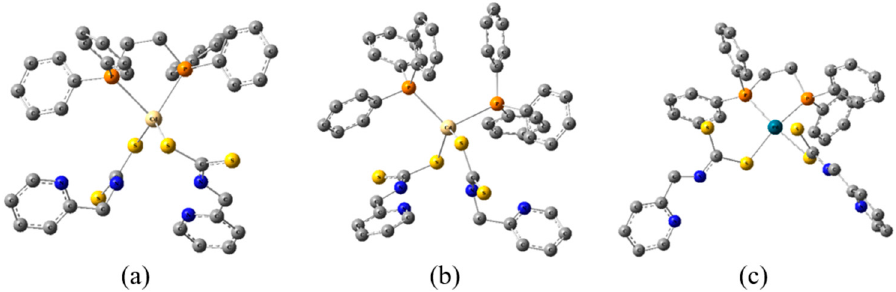
Figure 3. Optimized structures for ( a ) Cd(2) , ( b ) Cd(7) and ( c ) Pd(1) ; hydrogen atoms were not shown for simplicity.